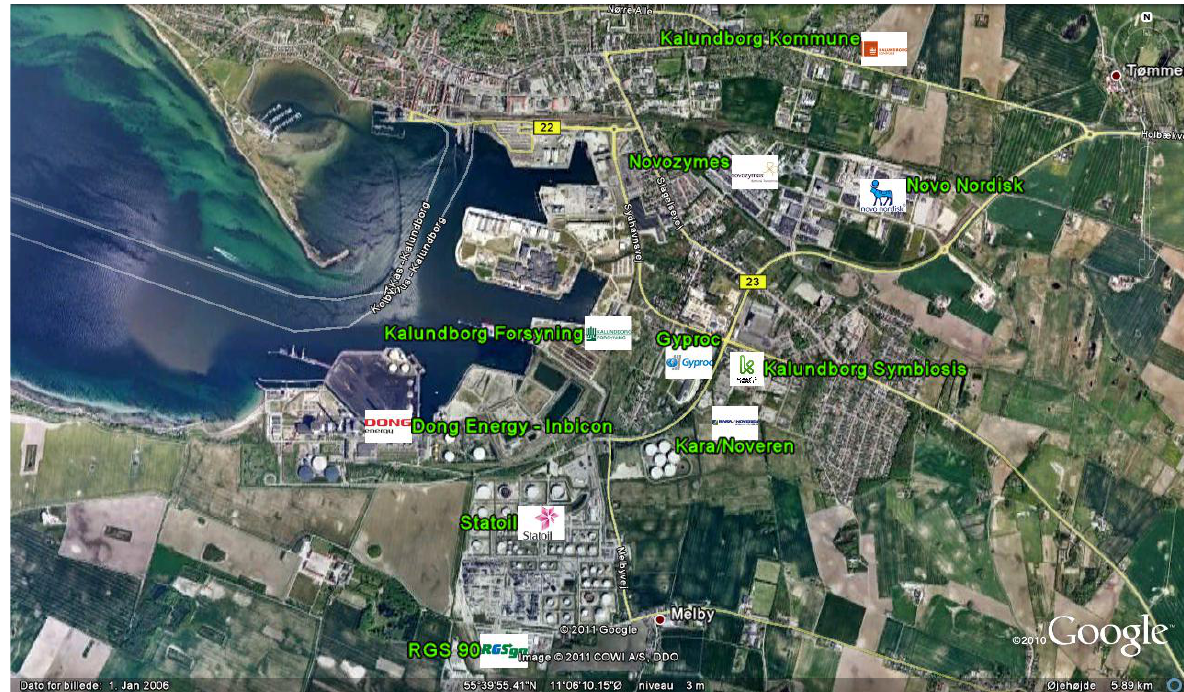
Figure 1. Industrial symbiosis. The Eco-Industrial Park (EIP) at the coastal city of Kalendborg, Denmark. The photo shows the location of the major industries that incorporate the